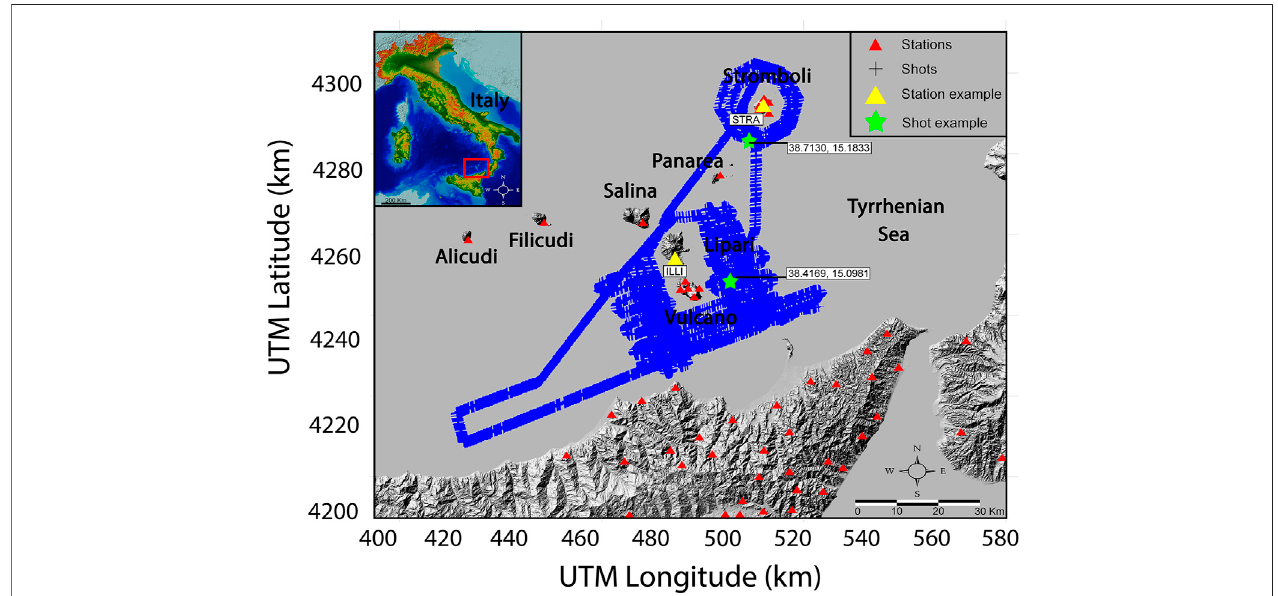
FIGURE 1 | Map of the study region. Red triangles represent the locations of seismic stations used in this study. Blue crosses are the locations of air-gun shots generatedduringtheTOMO-ETNAexperiment.Thehighlightedstations(yellowtriangles)andshots(greenstars)arethestationsandshotsusedasexamplesin Figures 2 , 3 . The Digital Elevation Model (DEM) used for this fi gure was obtained using the database of Tarquini et al. (2007).